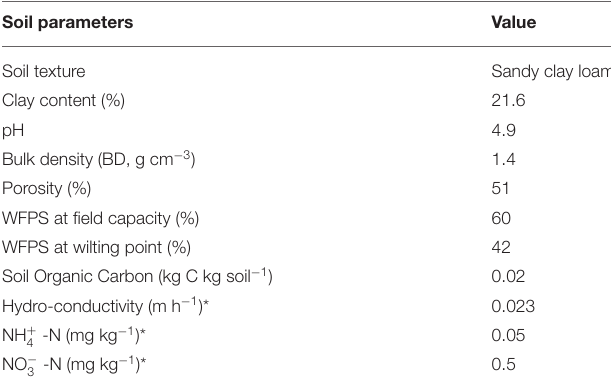
TABLE 2 | Soil parameters used in DNDC parametrization. Soil